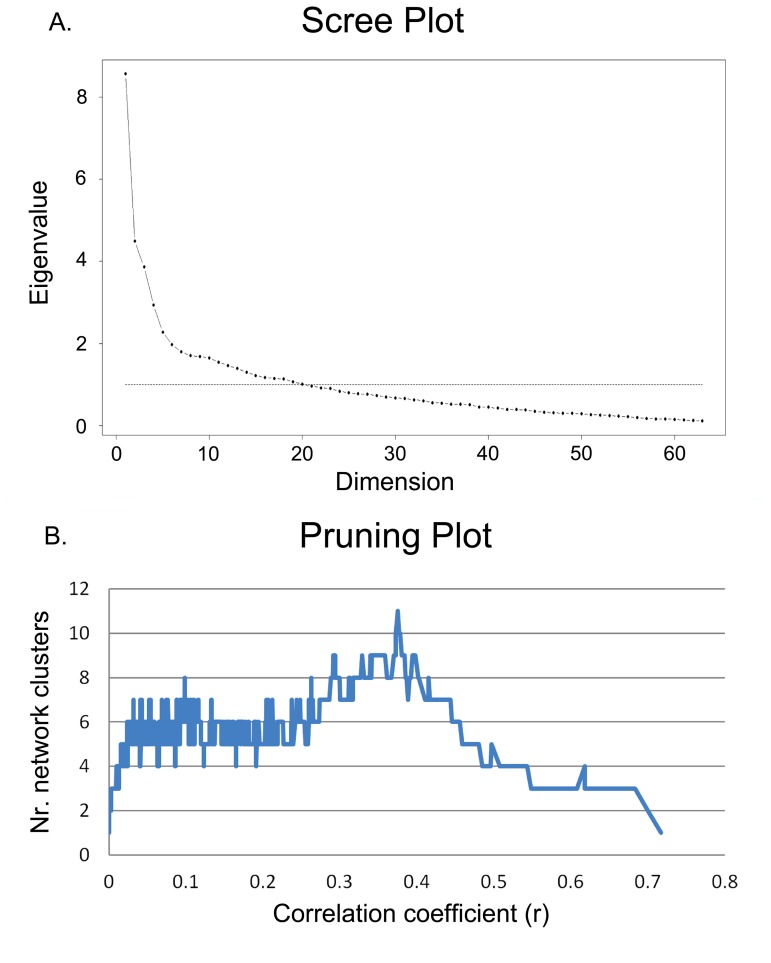
Scree-plot (A) and pruning plot (B) of the CPRS dataset.A. Scree-plot of the exploratory principal component analysis of the CPRS dataset, suggesting a 10-component structure. Defining a cut-off for the total number of components to extract was complicated by the lack of a clear bend in the plot. Hence, 5 additional alternative component structures were matched to the total array of possible network community structures of the dataset, to allow identification of an optimal solution. B. Incremental pruning plot of network community structure analyses showing the number of clusters in the Psychopathology Web as a function of the correlation coefficient that defines the threshold for significance of the links in the network. Neighborless nodes (isolates) are removed from the calculation and do not count as clusters.